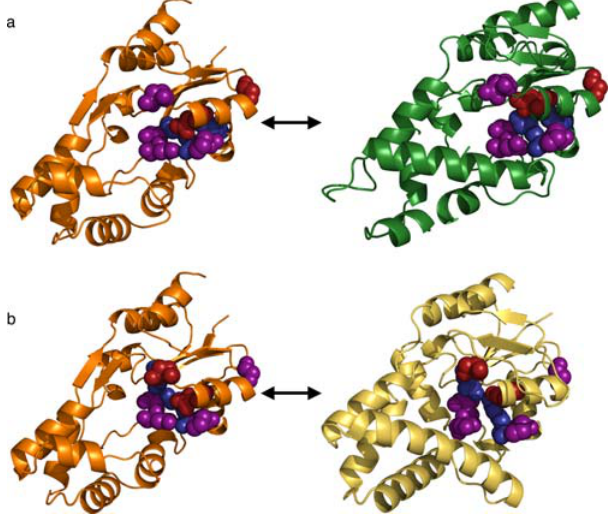
Figure 5. EC YihX and Matches. Comparison of structures and template/match residues for query 2b0c, chain A (4a and 4b, orange), from the Toronto Set versus targets 1 6 42, chain A (4a, green), and 1zrn (4b, yellow). Purple spheres, residues in both the source and target template and match; red spheres, residues in only the query template and target match; blue spheres, residues in only the target template and query match. doi:10.1371/journal.pone.0002136.g005 PLoS ONE |